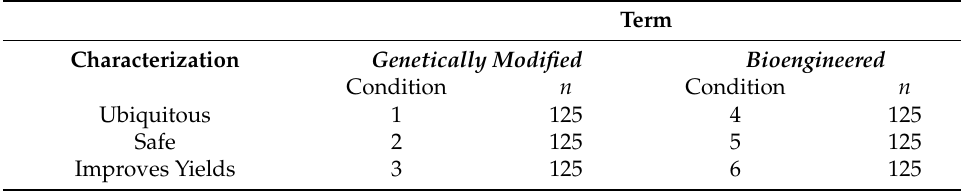
Table 1. Experimental Conditions and Sample Sizes. Term Characterization Genetically Modified Bioengineered Condition n